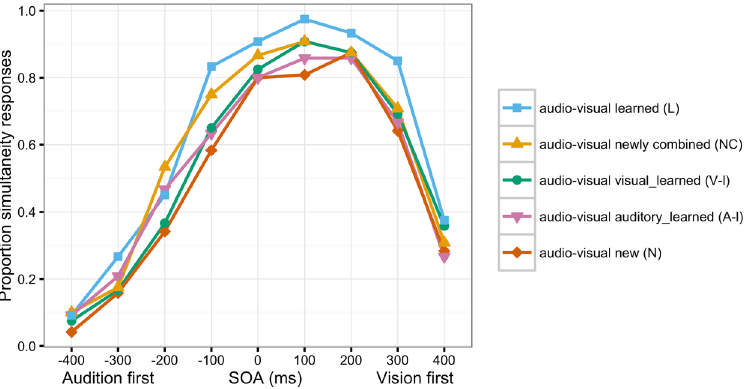
Figure 1. Mean proportion of ‘perceived simultaneity’ responses as a function of stimulus onset asynchrony (SOA) and first modality (negative values = auditory stimulus first, positive values = visual stimulus first) for audio-visual learned (L), audio-visual newly combined (NC), audio-visual visual_learned (V-l), audio-visual auditory_learned (A-l) and audio-visual new (N) stimuli.